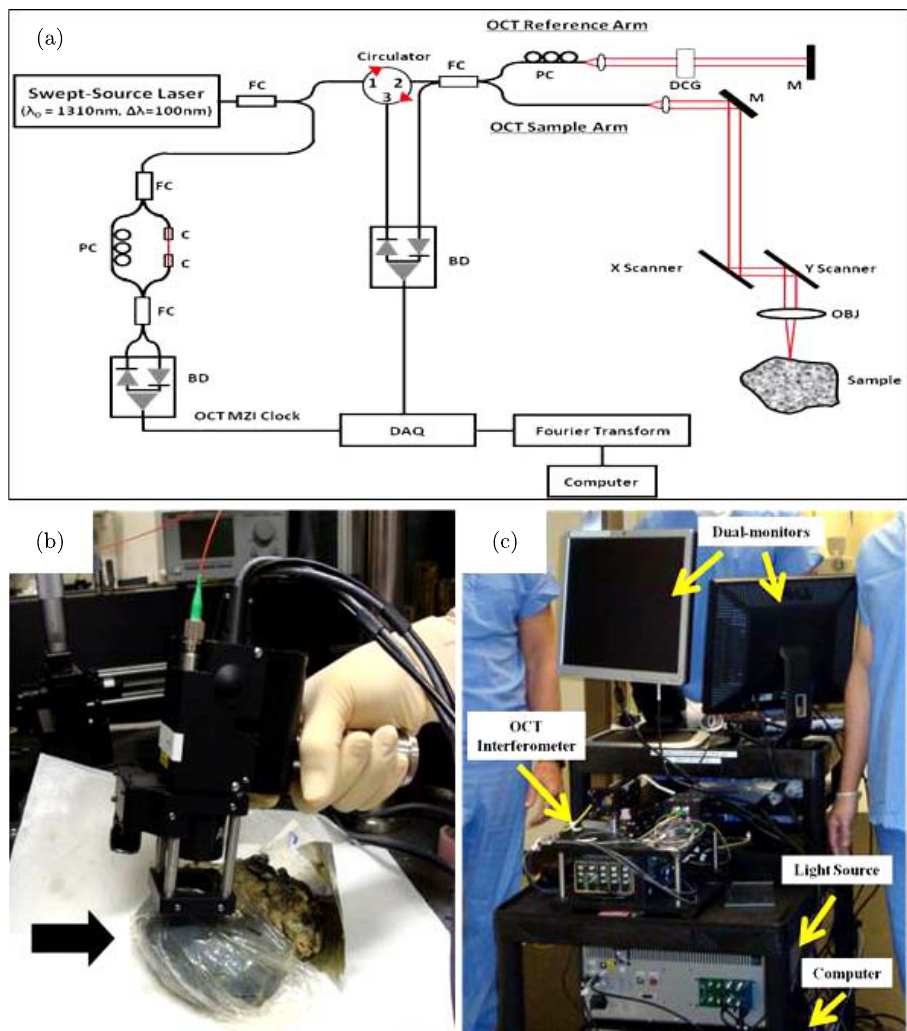
Fig. 1. (a) Schematics of hand-held OCT imaging probe for intra-operative kidney imaging. FC; ¯ber coupler, PC: polarization controller, C: collimator, MZI: Mach-Zehnder interferometer. M: mirror, BD: balanced detector, DAQ: data acquisition board. DCG: dispersion compensating glasses, OBJ: objective. (b) A close look of OCT hand-held probe. (c) Portable hand-held OCT imaging system setup for clinical imaging during kidney transplantation Dual-monitor output allows for simultaneous viewing by the physicians for evaluation and probe positioning and for our team for data